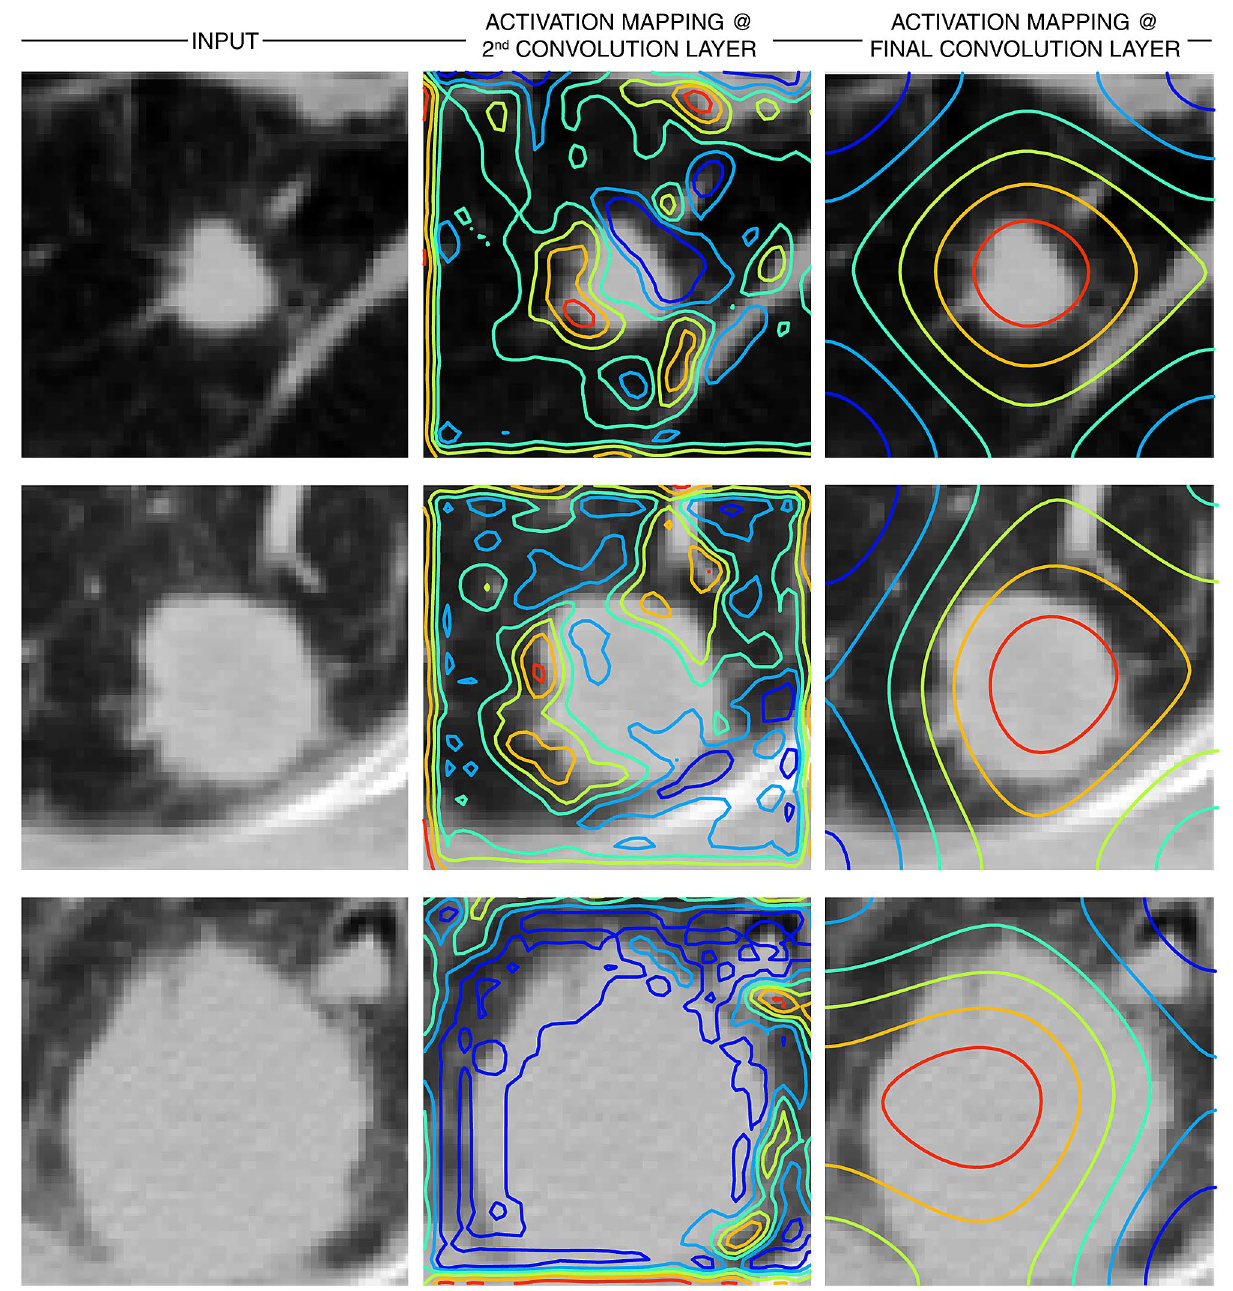
Figure 6. Gradient based class activation heat maps (Grad-CAM) for deep learning based model A . Visualization of image regions with the most discriminative value in type prediction as determined by the best performing convolutional neural network model. Here sample test input images are shown with overlaid activation contours, where red highlights regions with highest contribution and blue representing areas with the least value. The second and last convolutional layer in model A were used for generation of class activation maps as depicted by Fig.